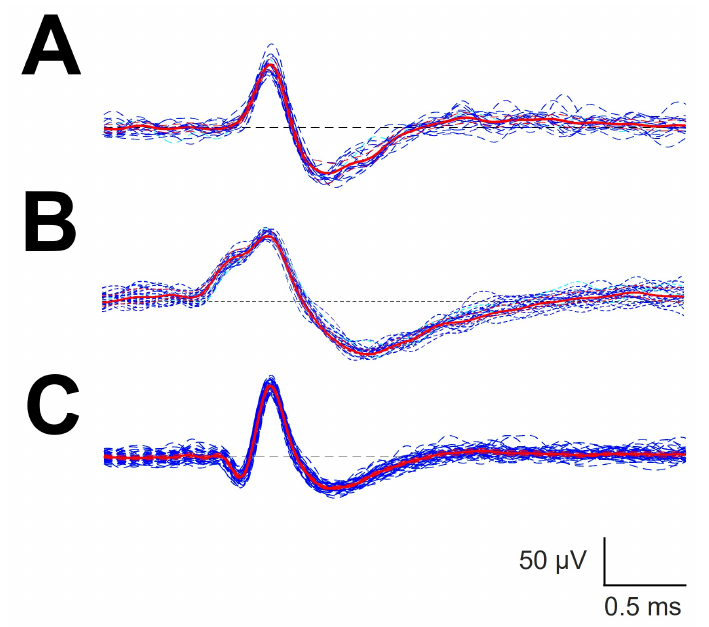
Figure A1. Automatic sorting of different types of canonical forms. ( A ) P1N1; ( B ) P1P2N1 and ( C ) N1P1N2. Blue lines are individual sorting EAP attributed to the same cluster. Red lines, mAP computed from the set of individual EAP.